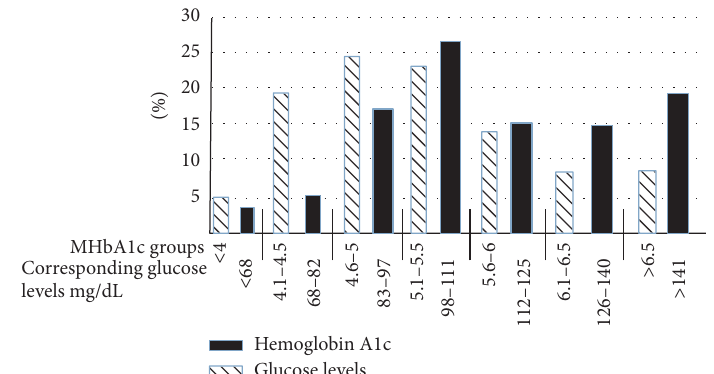
Figure 1: Percentage distribution of HbA1c and average glucose levels in 200 patients. The numbers on 𝑥 -axis represent the measured HbA1c groups and the expected glucose levels (mg/dL) for each group of measured HbA1c.